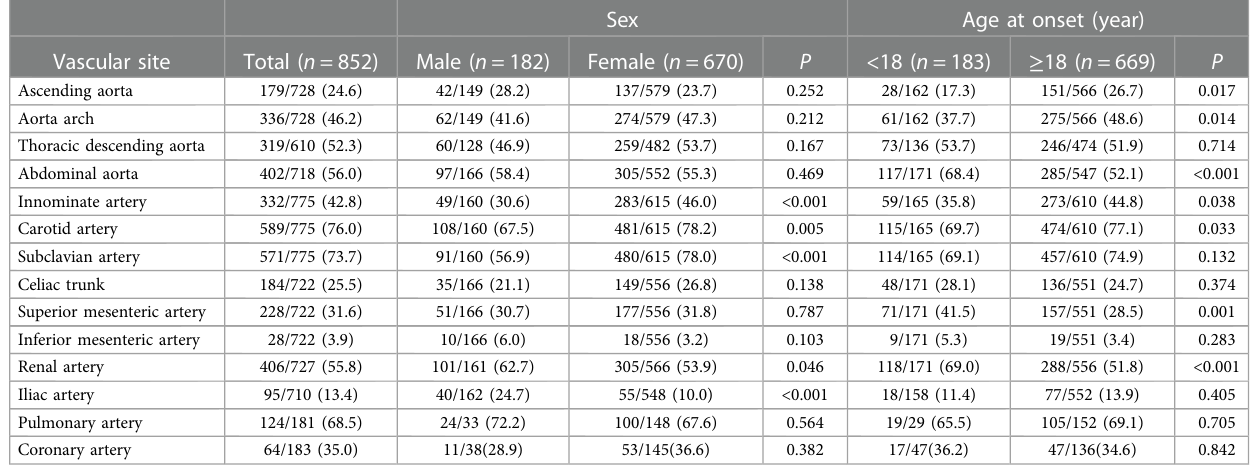
TABLE 1 Distribution of the arteries involved in TAK patients among the gender and age groups of onset [ n (%)].